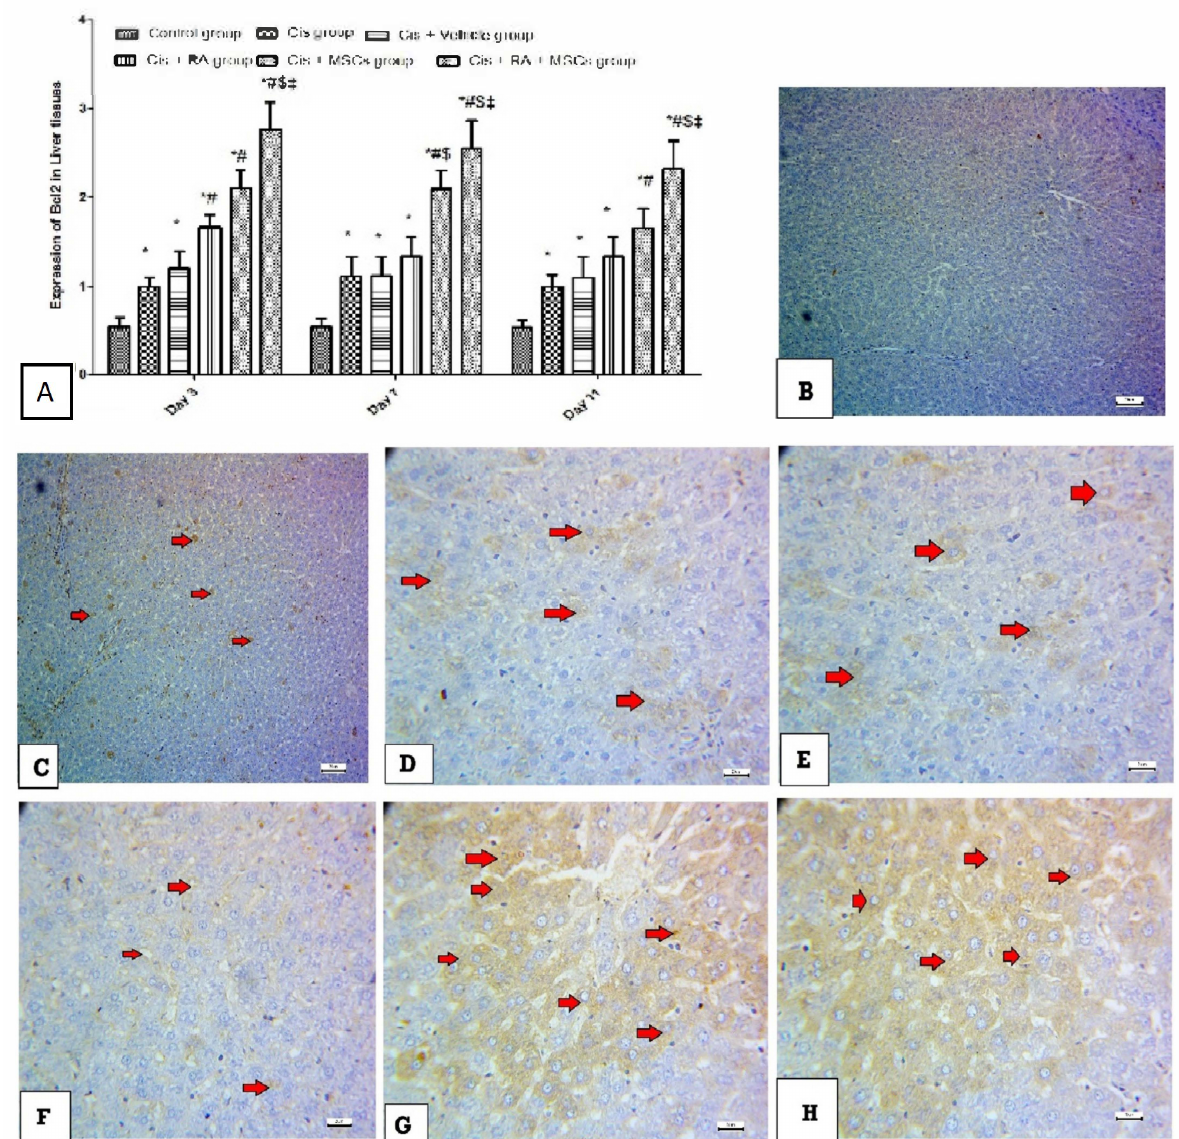
Figure 8. Immunohistopathological examination for the expression of Bcl2 in liver specimens. The score of Bcl2 expression in liver at different time intervals (3 days, 7 days and 11 days) showed significant rise in its expression in Cis group with significant rise in all treated groups (Cis + RA, Cis + BM-MSCs, Cis + RA+BM-MSCs groups) ( A ). Microscopic pictures of immunostained hepatic sections for Bcl2 from rats groups sacrificed at day 11 showing minimal staining in control group (( B ) 100 × ), increased positive brown expression of Bcl2 (red arrows) in hepatocytes in Cis group group at day 11 (( C ) 100 × and ( D ) 400 × ) and vehicle group (( E ) 400 × ) and more upregulation Bcl2 expression in treated groups where positive cytoplasmic brown expression (red arrows) in hepatocytes is moderate in group treated with RA group (( F ) 400 × ), MSCs group (( G ) 400 × ), to marked expression in group treated with MSCs & RA group (( H ) 400 × ). * Significant vs. Control group, # significant vs. Cis group, $ significant vs. Cis + MSCs group and ‡ significant vs. RA